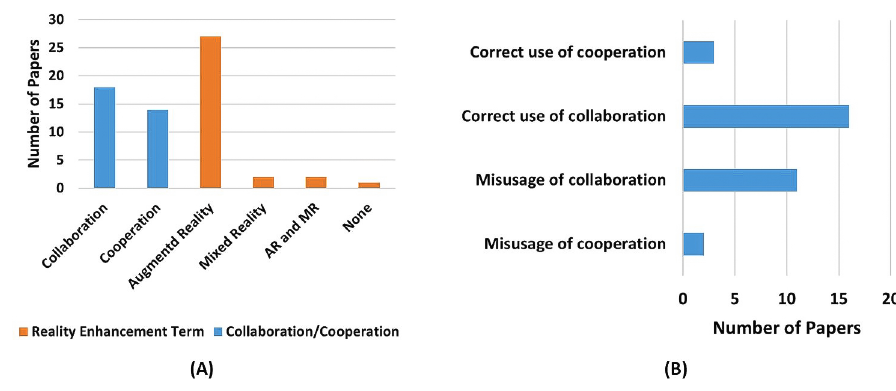
Figure 7. ( A ) number of papers by term; ( B ) correct usage of collaboration and cooperation according to Section 2